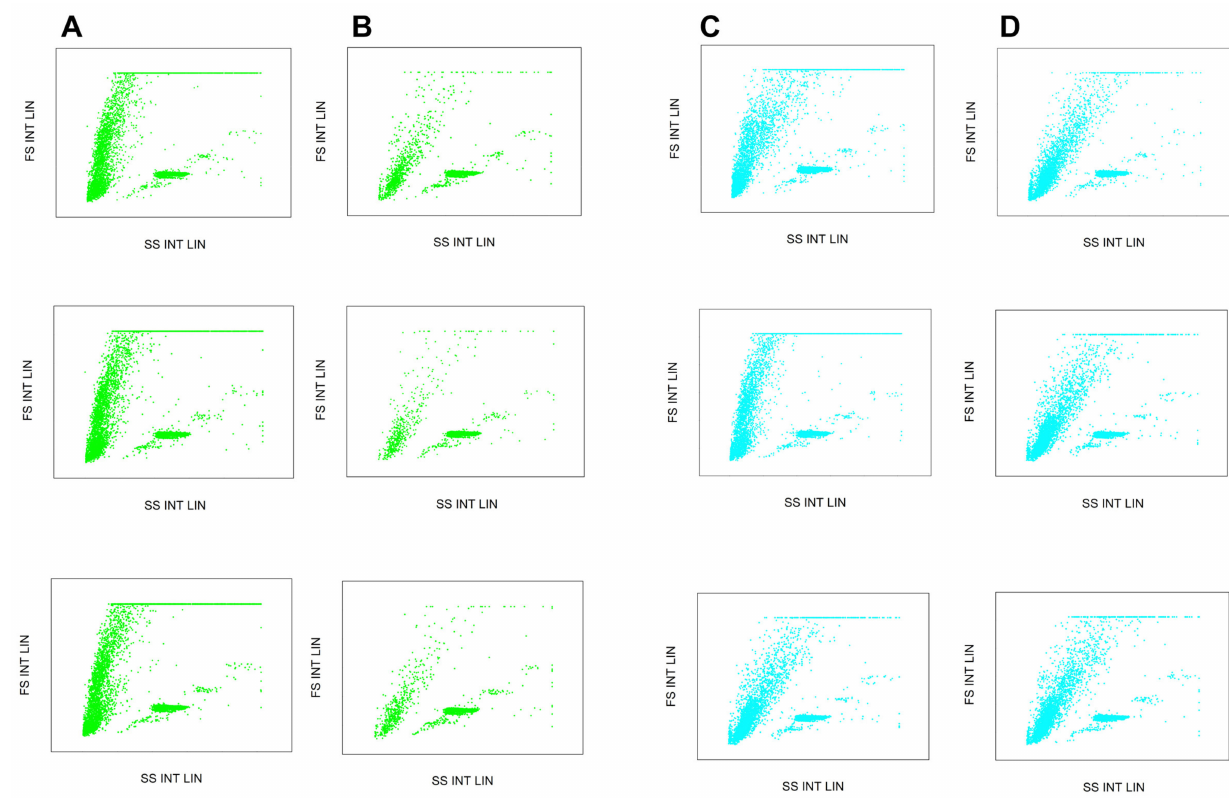
Figure 3. Quantitative flow cytometry assessment of CTC capture efficiency. Dot plots show the populations of HCT116 cells as well as the applied internal standard. Columns ( A , B ): initial and run-through events of the EpCAM immobilized fiber experiments. Rows show the repeatability of the triplicate measurements. Columns ( C , D ): initial and run through events of the control fiber